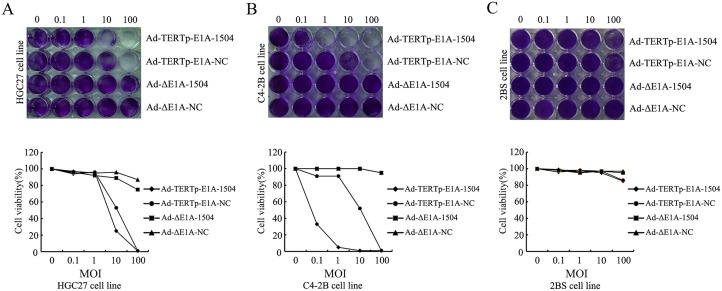
Ad-TERTp-E1A-1504 enhances oncolytic potency.C4-2B, HGC27, and 2BS were infected with Ad-TERTp-E1A-1504, Ad-TERTp-E1A-NC, Ad-△E1A-1504, or Ad-△E1A-NC at the indicated MOIs. After 3 days, adherent cells were stained with crystal violet and quantified. Data represent examples of two independent sets of experiments. A-B: Ad-TERTp-E1A-1504 killed almost all tumor cells at 1–10 MOI, however Ad-TERTp-E1A-NC had the same effect at 100 MOI and Ad-ΔE1A-1504 or Ad-ΔE1A-NC killed fewer cells at 100 MOI. C: Compared with tumor cell lines, 2BS was less sensitive to Ad-TERTp-E1A-1504 (few cells died at 100 MOI).